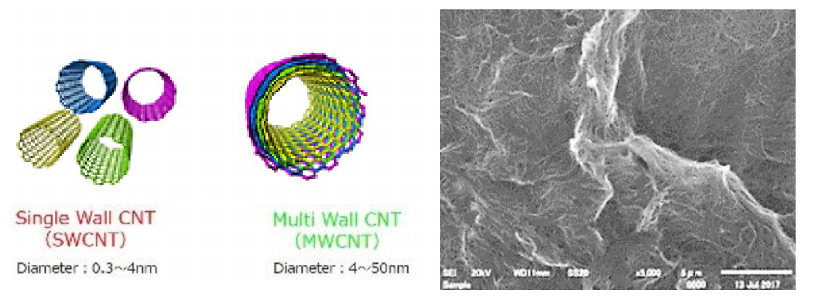
Figure 1. Illustration of SWCNTs and MWCNTs and a photo of dispersed SWCNTs (SEM 5000 ×